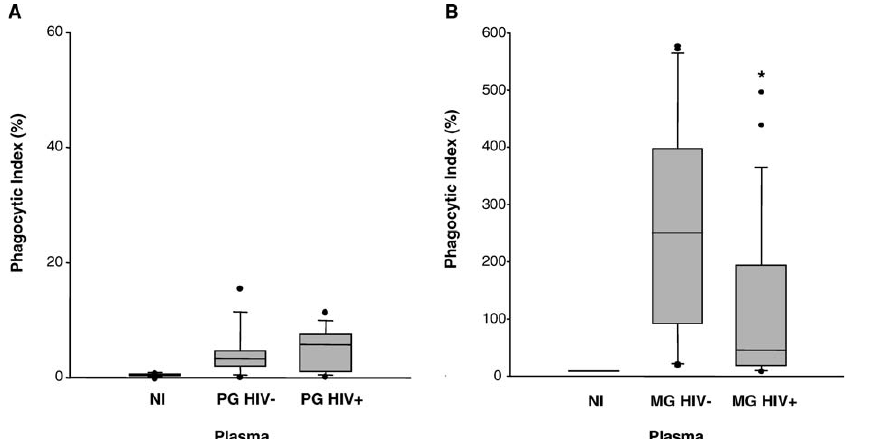
Figure 4. HIV-Infected Multigravid Women Have Impaired Plasma Opsonizing Activity against CSA-Binding Parasitized Erythrocytes Box (median and IQR) and whisker (range) plot showing phagocytic index of CS2 PEs opsonized with plasma from (A) NI ( n ¼ 6), PG HIV (cid:2) ( n ¼ 9), or PG HIV þ ( n ¼ 11) donors, and (B) NI ( n ¼ 2), MG HIV (cid:2) ( n ¼ 23), or MG HIV þ ( n ¼ 23) donors. Statistical significance was assessed by Mann-Whitney rank sum test. *MG HIV (cid:2) versus MG HIV þ p ¼ 0.006. MG HIV þ , HIV-infected MG; MG HIV (cid:2) , HIV-negative MG; NI, nonimmune; PG HIV (cid:2) , HIV-negative PG; PG HIV þ , HIV-infected PG.